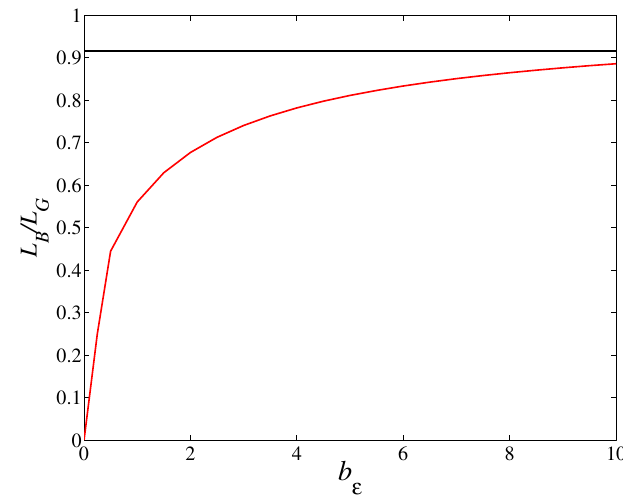
FIG. 2. (Color) Growth rate for fixed brightness as a function of emittance after optimizing over the energy spread. The effect of diffraction is assumed to be negligible.